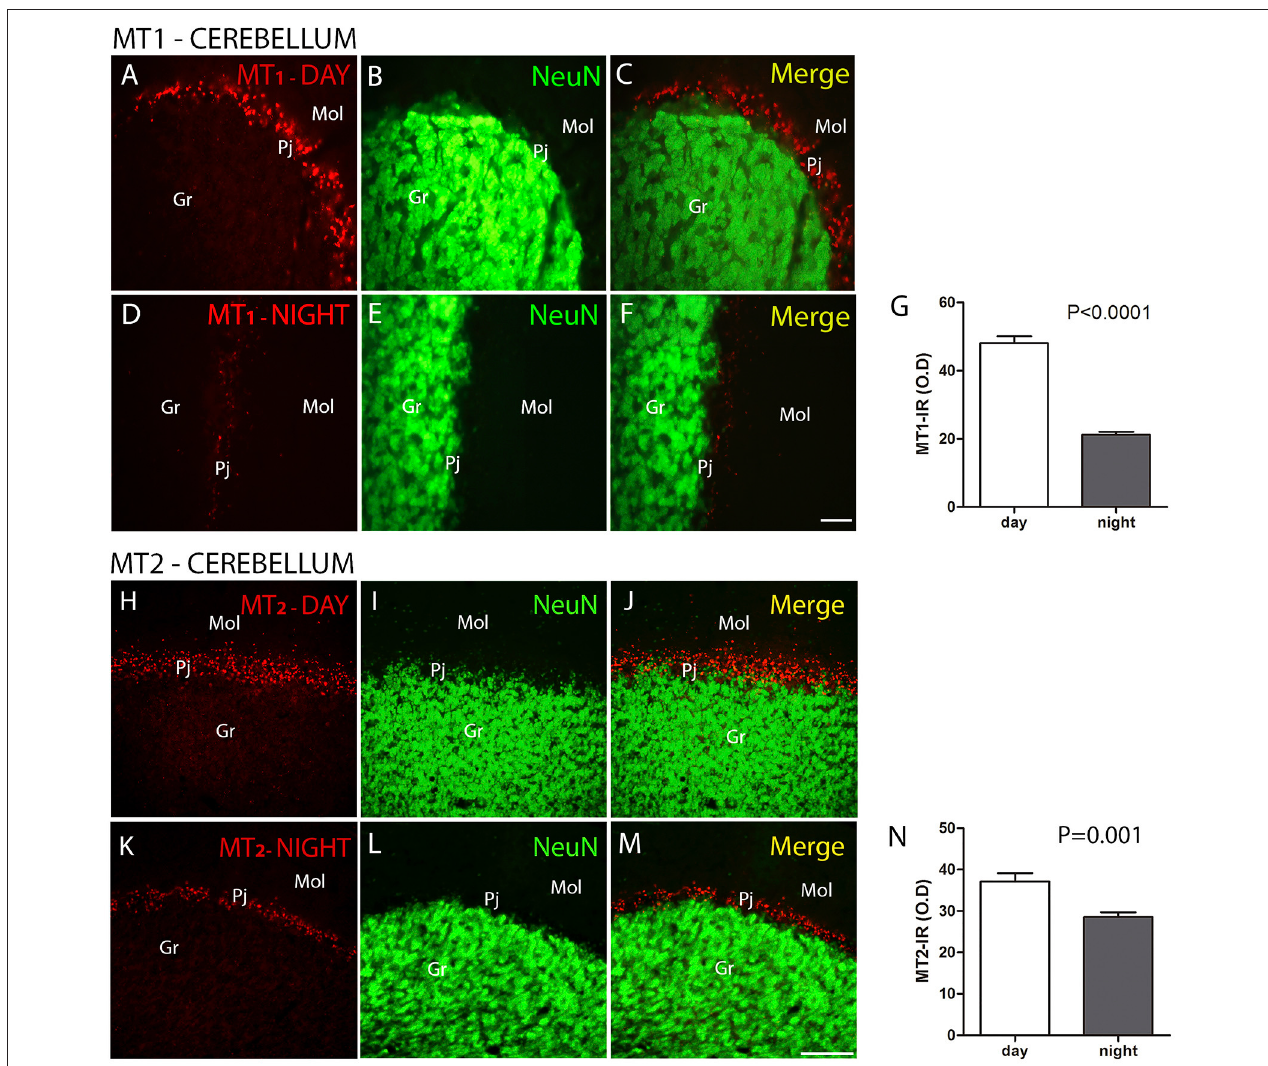
FIGURE 2 | The distribution of MT 1 and MT 2 proteins in the cerebellar cortex in the primate Sapajus apella. Photomicrographs of frontal brain sections show MT 1 protein (A–F) (red) or MT 2 protein (H–M) (red) and NeuN cells (green) at two time points, one during the day (ZT 10) and another at night (ZT 19). The graphs show the means ± standard error of the mean of the IR intensity (O.D) quantification of MT 1 -IR cells (G) or MT 2 -IR cells (N) in the Purkinje cell layers of monkeys perfused at day or nighttime points. Bar = 50 µ m. Purkinje cell layer (Pj); molecular layer (mol); granular layer